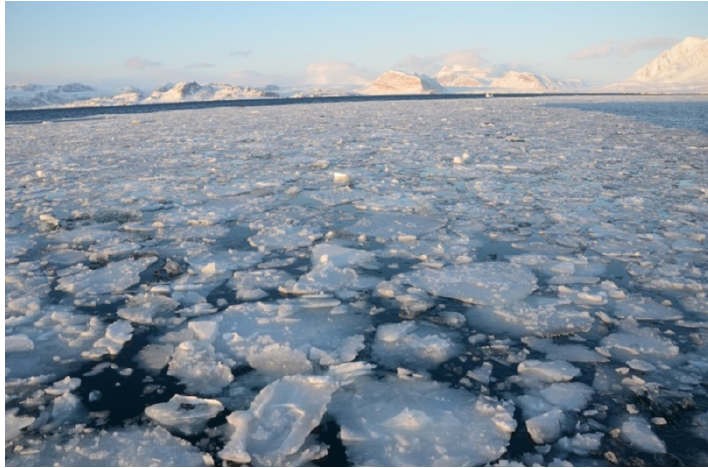
Figure 11. Sea ice in Kings Bay, Ny-Ålesund on 26 April at 21:00UTC, 2015 (at Ny-Ålesund Dock, photograph by Yuhan Luo).